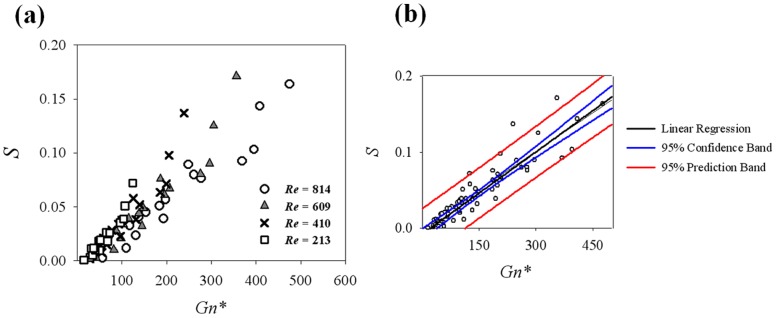
Variations of swirling intensity (S) with respect to Gn*.(a) Effect of Re on swirling intensity variation, (b) a linear regression curve (S = 0.0004×Gn*–0.0075, R2 = 0.834) and 95% confidence and prediction bands.